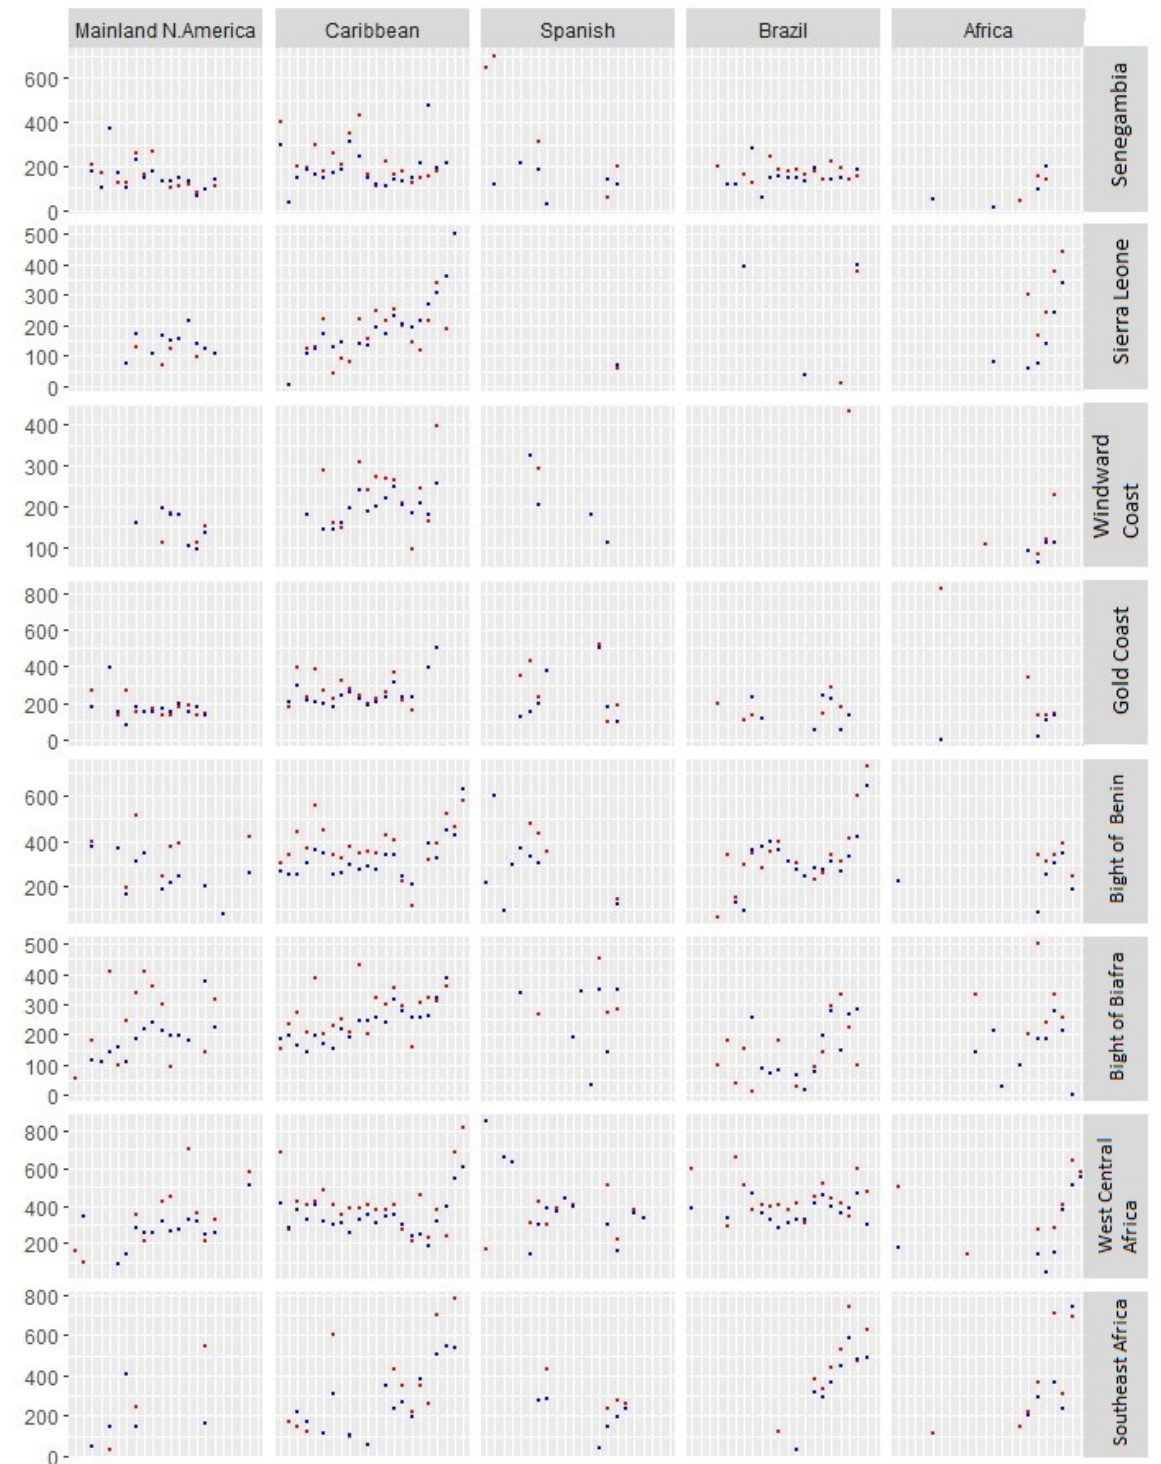
Figure 4. Known captive flows for all voyages by route. Average embarkation (red) and arrival (blue) populations per voyage, by route by